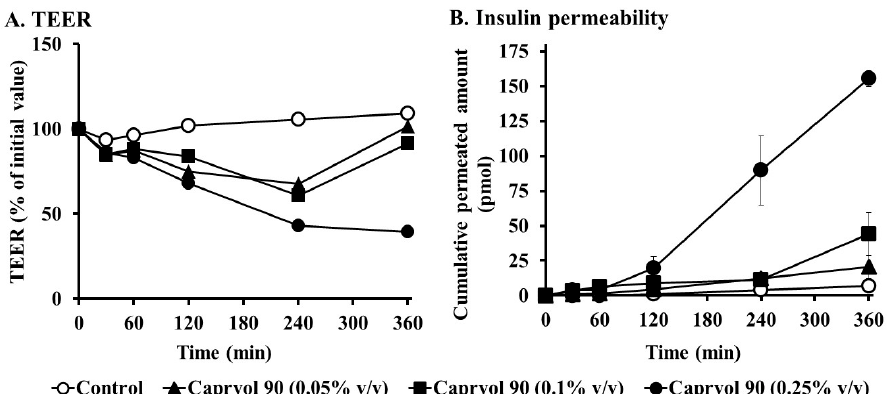
Figure 8. Effect of Capryol 90 with different concentrations on transepithelial electrical resistance (TEER) and permeation of insulin through Caco-2 cell monolayers. ( A ) TEER values (TEER % of initial value). ( B ) Cumulative permeated amount of insulin in the presence of Capryol 90. Each value represents the mean ± S.E. ( n = 3).